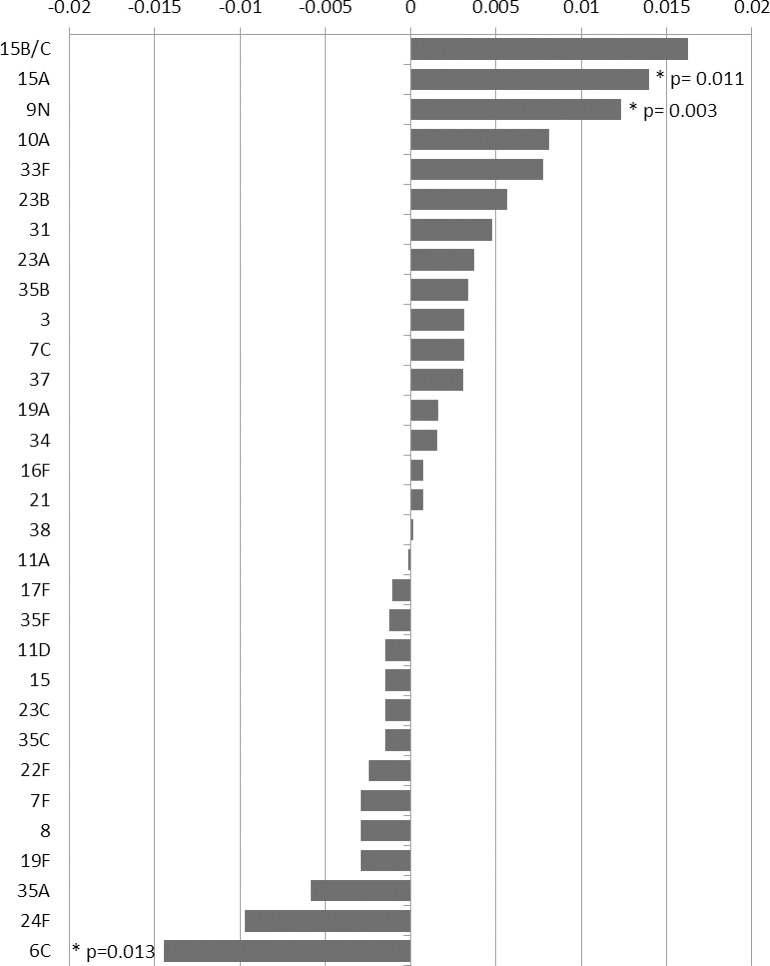
Change in prevalence of serotypes (measured as the difference in proportions of all swabs taken that were culture positive for that serotype) in those aged <60 years between the 2012/13 and 2015/16 carriage surveys.P values shown for serotypes where the changes was <0.05.